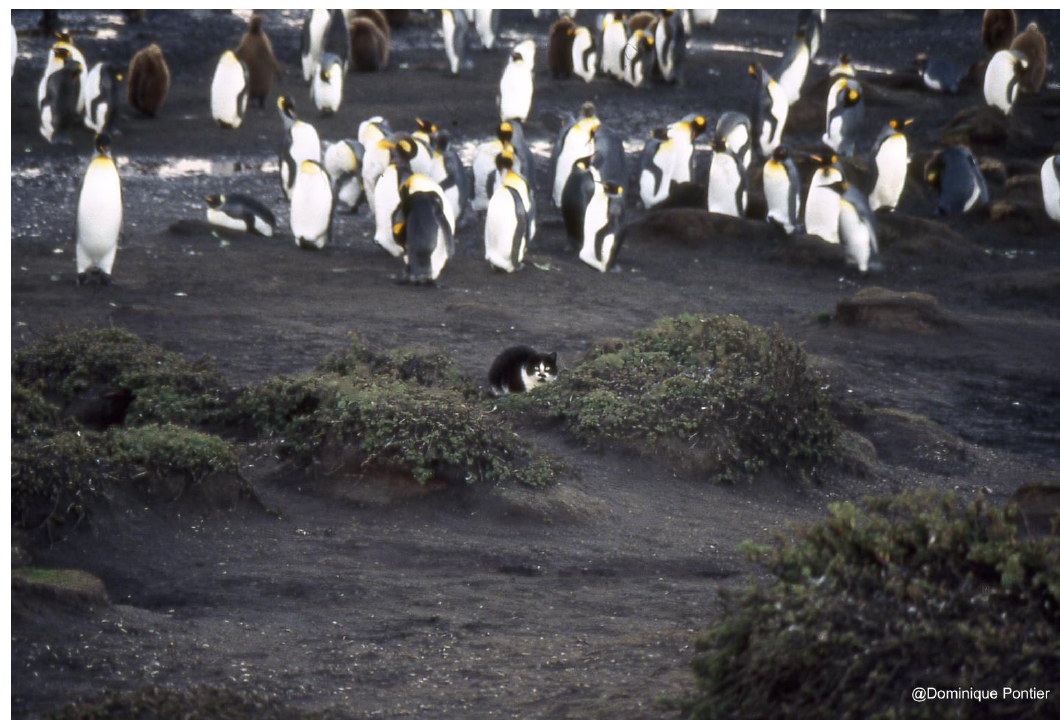
Figure 1. Domestic cat photographed at the Ratmanoff penguin farm zone (Grande Terre, Kerguelen Archipelago). The cats eat the carrion of young penguins or rabbits that have dug burrows in the vicinity of the penguin farm zone (credit Dominique Pontier). They therefore live a solitary lifestyle, very similar to that of the European wildcat ( Felis s. silvestris Schreber, 1777) [11]. At the other extreme are the urban unowned free-ranging domestic cats (FRCs), living in colonies in the urban environment at a very high density (more than a thousand individuals per km 2 ) and within a social spatial organisation [12–17] (Figure 2).